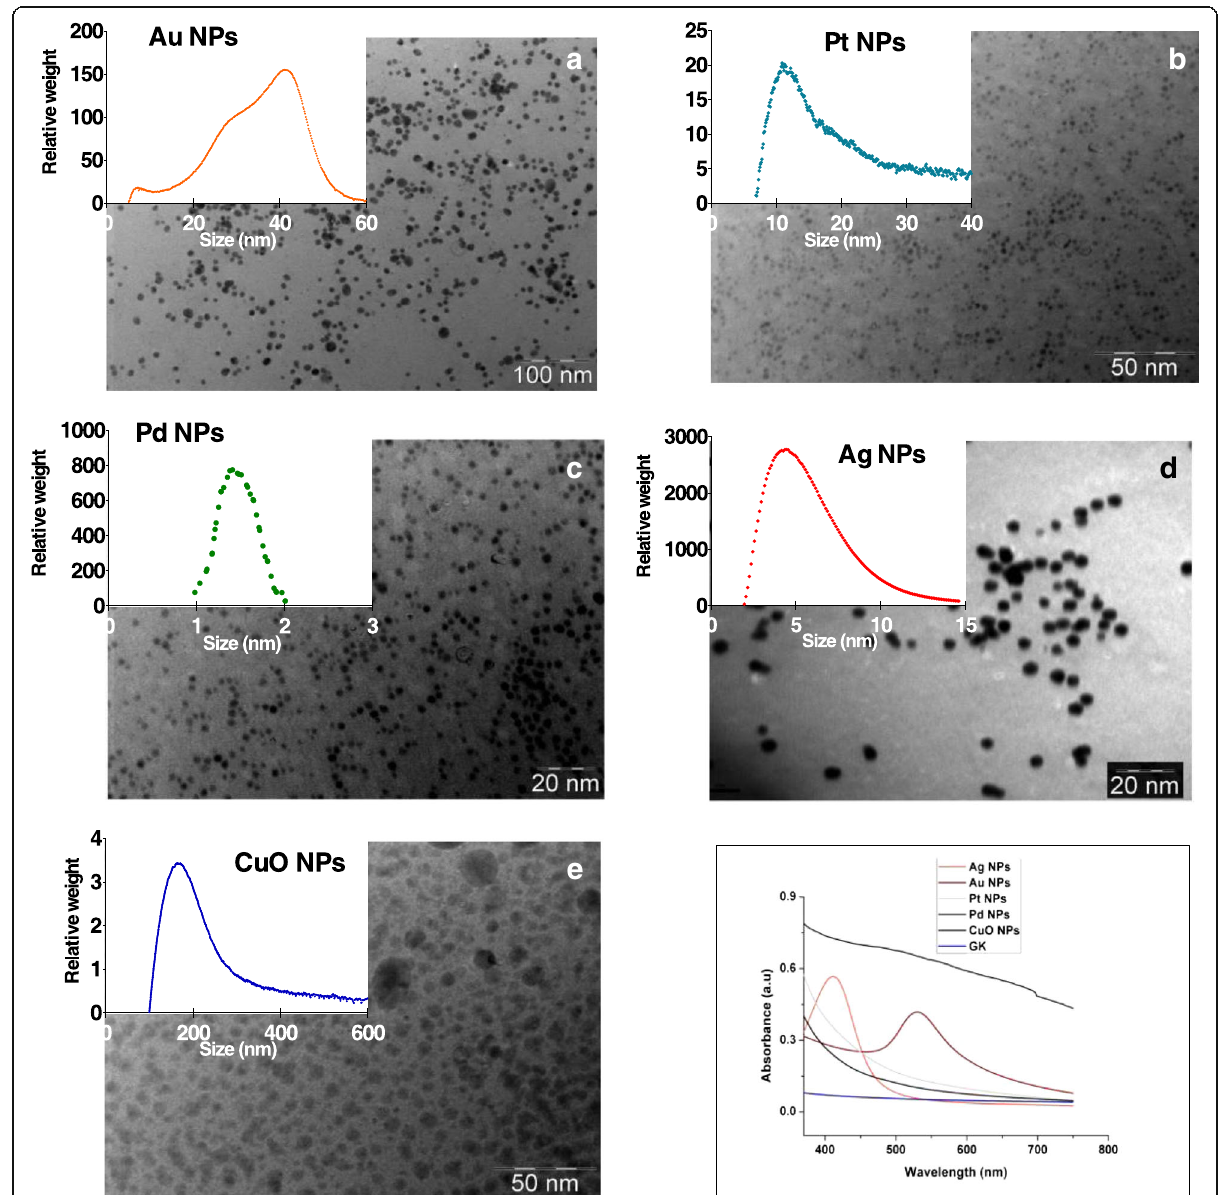
Fig. 1 Transmission electron microscopy images of a Au, b Pt, c Ag, d Pd and e CuO nanoparticles synthesised using gum karaya and their corresponding metal salts. a , b , c , d and e graph inserts show the peak particle size distribution by nanoparticle weight in algal media, as determined by differential centrifugal sedimentation. (F) UV – Vis spectra for the Au, Ag, Pt, Pd and CuO